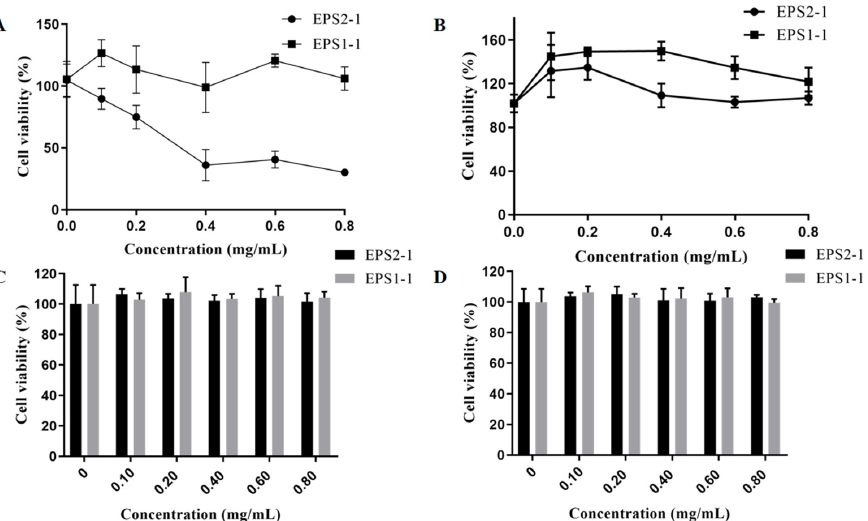
Figure 8. Effect of EPS2 ‐ 1 on the proliferation of tumor and RAW264.7 cells. ( A ) MFC cells; ( B ) RAW264.7 cells; ( C ) SPCA1 cells; ( D ) H1299 cells were treated with EPS2 ‐ 1 for 24 h, and the cell